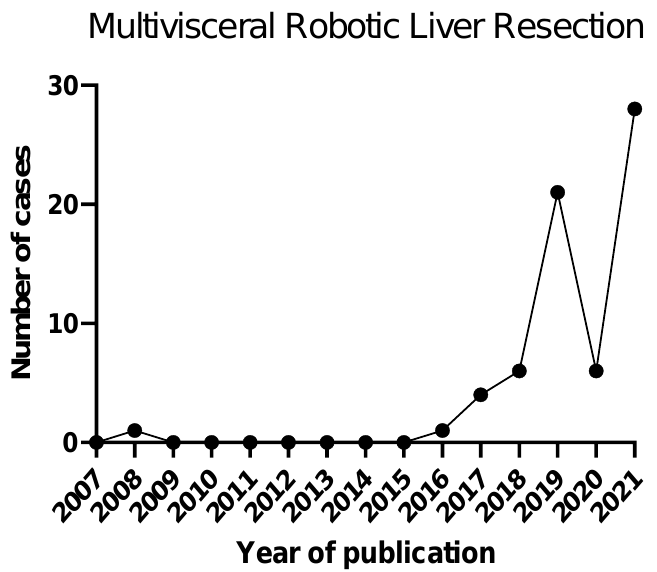
Figure 1. Trend of published cases of multivisceral robotic resection over time.